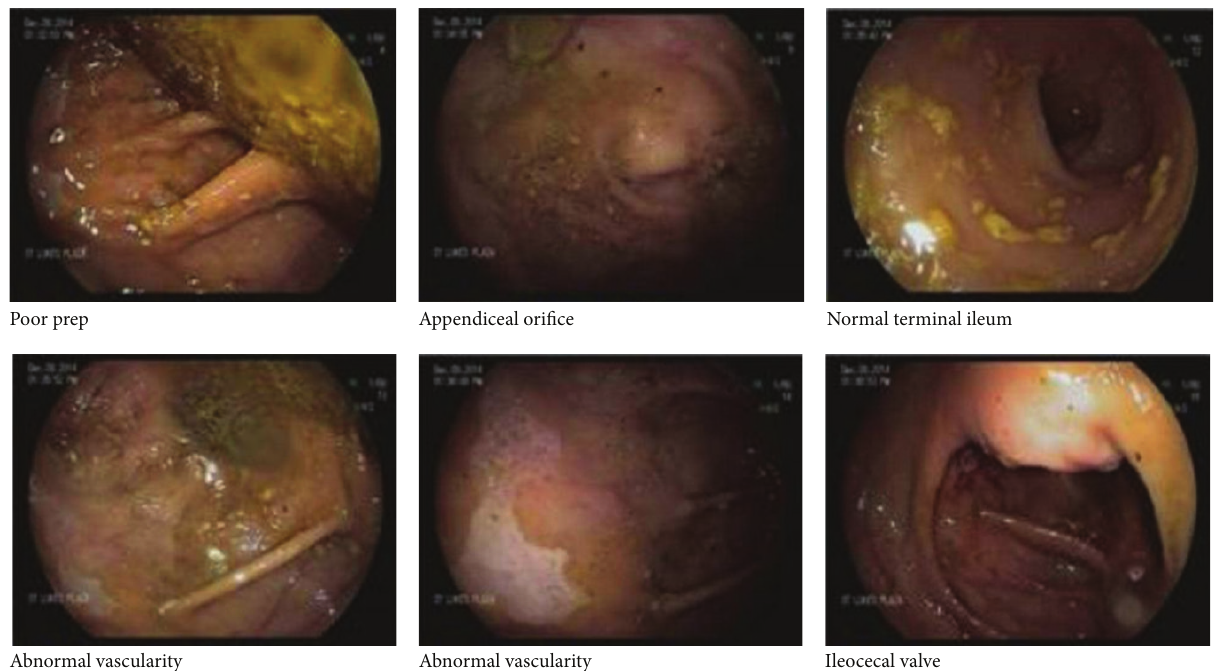
Figure 1: Endoscopic findings of abnormal vascularity, congestion, erosions, nodularity, granularity, erythema, and ulceration of the cecum and ascending colon consistent with ischemic colitis.